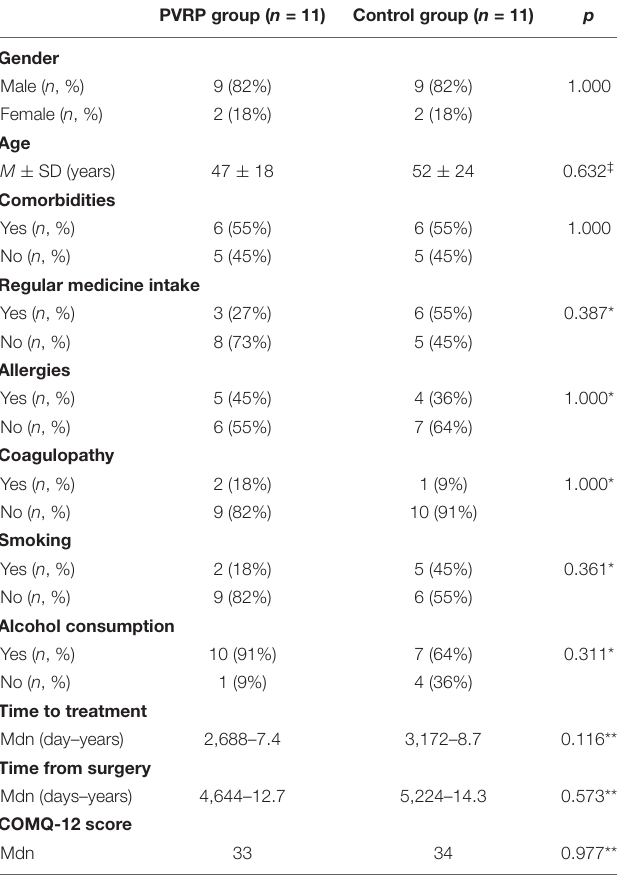
TABLE 1 | Baseline characteristics of the